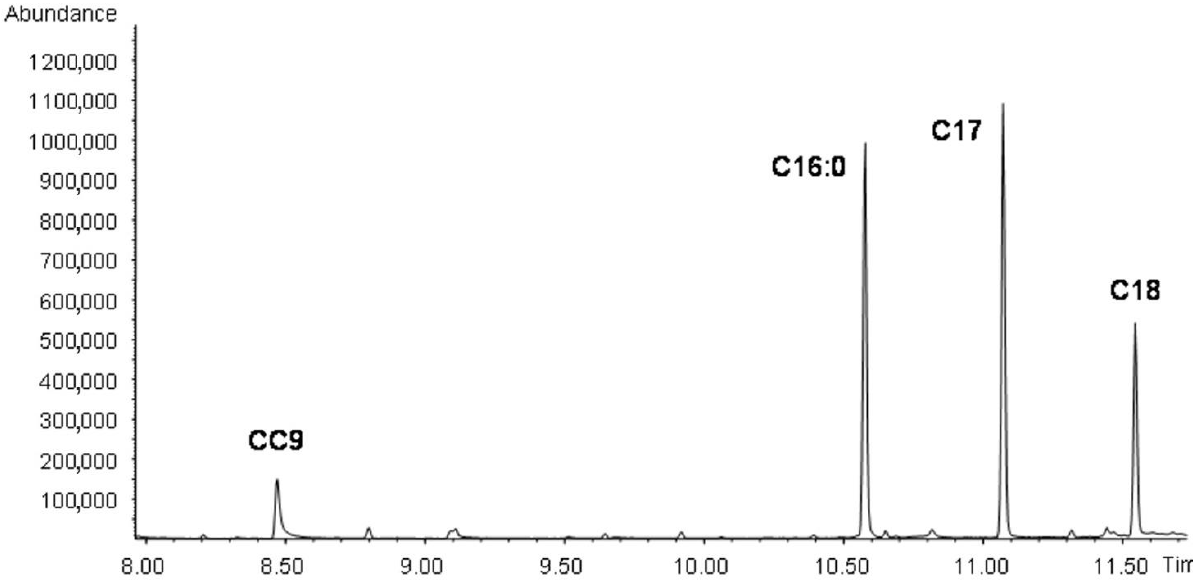
Figure 9. GC-MS chromatogram of the lipidic fraction of the B2 sample (gilding sample with frag- ments of gold taken from the central garland around the Christ). CC9 = azelaic acid, C16:0 = palmitic acid, C17: tetracosane (internal standard), C18:0 = stearic acid.